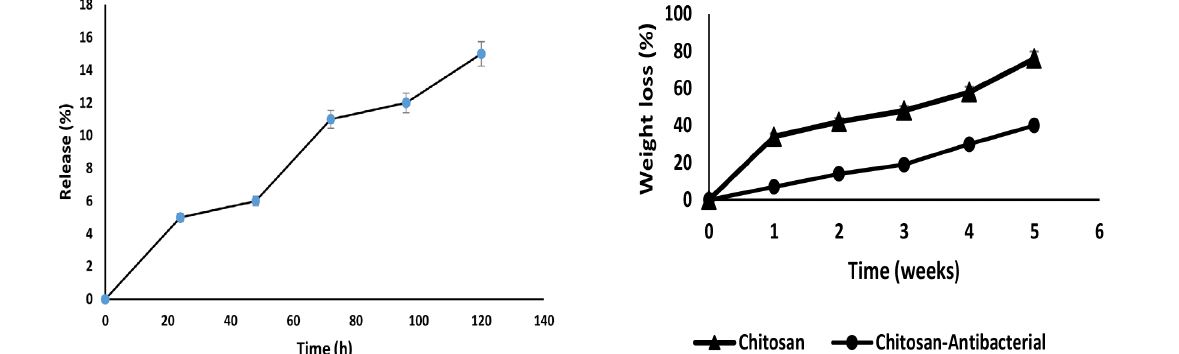
Table 3. The MIC (µg/ml) of Chloramphenicol for Staphylococcus aureus ATCC 6538 and Escherichia coli ATCC 11303 was 2 and 0.5, respectively.